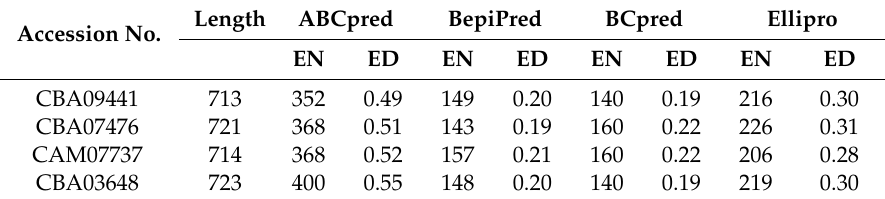
Table 3. Linear B-cell epitope densities of proteins.